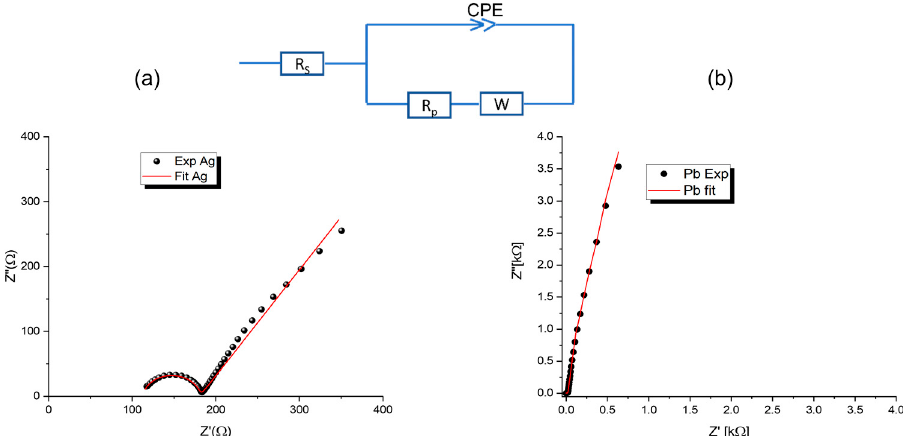
Figure 4. The electrical equivalent circuit for the sample being tested is shown in the inset, along with the associated Nyquist plots. The red line represents the best fit based on this circuit, while the scatter points represent the experimental results ( a ) Silver and ( b ) Lead.